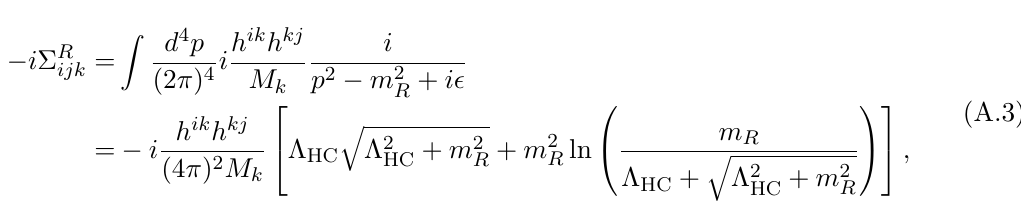
JHEP09(2021)167